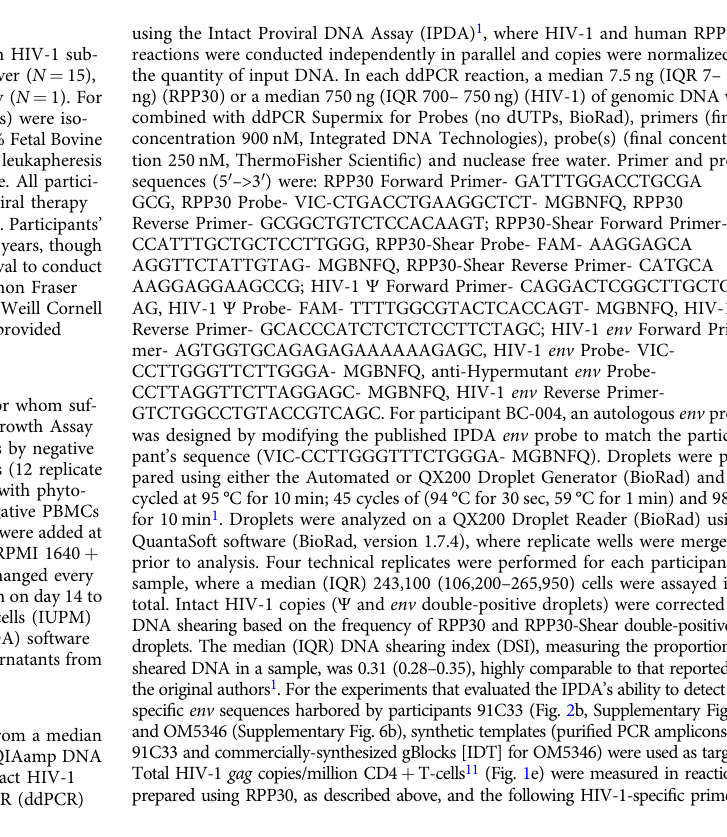
Fig. 4 Performance of the secondary env primer/probe set. a A secondary env primer/probe set rescued detection in all 9 cases of IPDA env detection failure ( p = 0.004, two-sided Wilcoxon signed-rank test). b A secondary env primer/probe set performs comparably to the IPDA in samples detectable by the latter assay. Black datapoints denote 33 participants whose reservoir was detectable by both IPDA and secondary env primer/probe sets; red datapoints denote three participants whose reservoir was detectable by IPDA but not using the secondary env primer/probe set. Excluding the latter three points yielded a Spearman ’ s ρ = 0.82, p < 0.0001 (shown on fi gure). Including these three red datapoints yielded a Spearman ’ s ρ = 0.68, p < 0.0001. Datapoints show point estimate from four merged technical replicates for each participant sample. Source data are provided in the Source Data